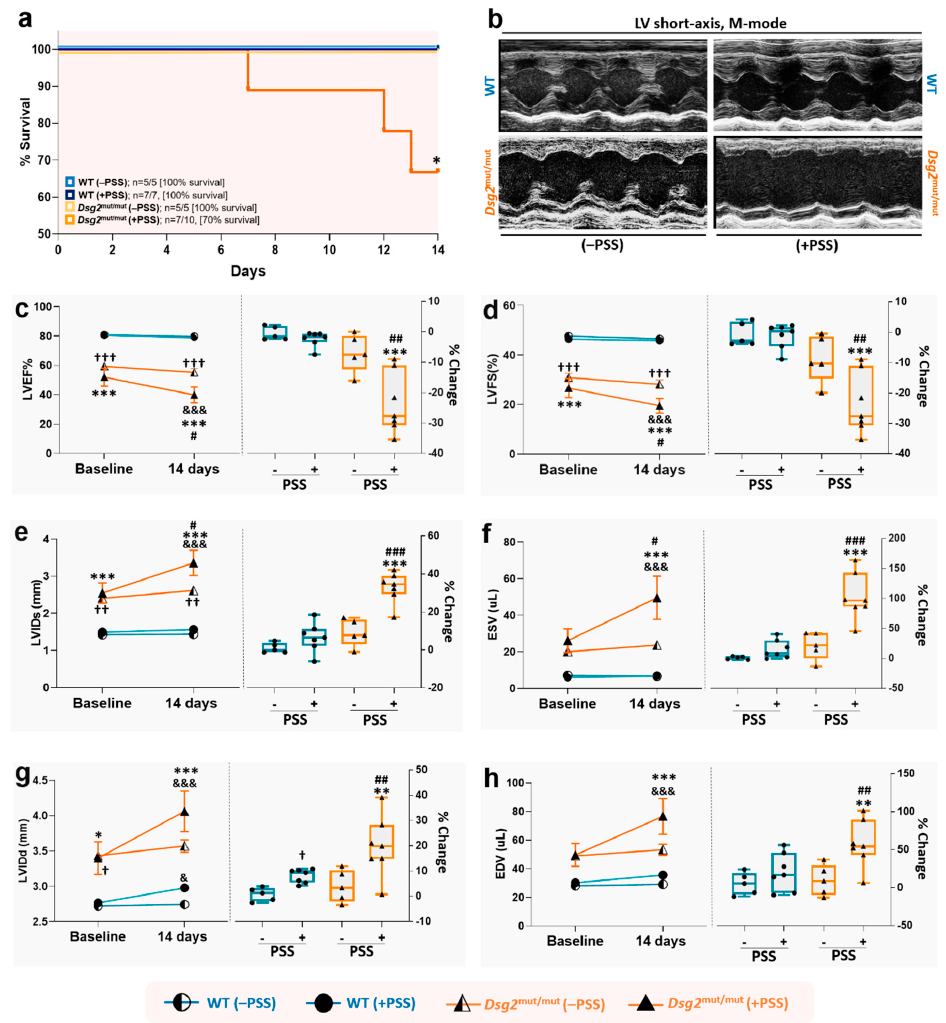
Figure 4. Psychosocial stress increases the risk of sudden death and worsens cardiac function in Dsg2 mut / mut mice. ( a ) Percent (%) survival curve in non-stressed (–PSS) and stress-induced ( + PSS) WT and Dsg2 mut / mut mice. PSS, psychosocial stress. Data presented as % survival and n-values inset; * p < 0.05 for Dsg2 mut / mut ( + PSS) vs. all cohorts via Wilcoxon survival test. ( b ) Representative left ventricular (LV) short-axis, m-mode echocardiography. Images representative of n = 5–7 mice / cohort. For c – h , the trend of echocardiographic parameters (y-axis) over time (x-axis) is shown on the left panels; and the percent changes (% Change) from baseline to the end of the protocol for each cohort, is shown on the right panels. ( c ) Percent Left Ventricular Ejection Fraction (LVEF%); ( d ) Percent Left Ventricular Fractional Shortening (LVFS%); ( e ) Left Ventricle Internal Diameter at systole (LVIDs; mm); ( f ) End Systolic Volume (ESV; µ L); ( g ) Left Ventricle Internal Diameter at diastole (LVIDd; mm); and ( h ) End Diastolic Volume (EDV; µ L). Data in left panels are presented as mean ± SEM; n = 5–7 mice / cohort / parameter; & p < 0.05; &&& p < 0.001 any cohort (at 14 days) vs. same cohort (at baseline) within cohort study, using two-way ANOVA with Sidak’s multiple comparisons post-hoc analysis; and * p < 0.01, *** p < 0.001 Dsg2 mut / mut ( + PSS) vs. WT ( + PSS) and WT ( − PSS); # p < 0.05 Dsg2 mut / mut ( + PSS) vs. Dsg2 mut / mut ( − PSS), † p < 0.05, †† p < 0.01, ††† p < 0.001 Dsg2 mut / mut ( − PSS) vs. WT ( + PSS) and WT ( − PSS), between cohort study, using two-way ANOVA with Tukey’s posthoc analysis. Data in right panels presented as box-whisker plots, n = 5–7 mice / cohort / parameter; ** p < 0.01, *** p < 0.001 Dsg2 mut / mut ( + PSS) vs. WT ( + PSS) and WT ( − PSS); † p < 0.05 WT ( + PSS) vs. WT ( − PSS); ## p < 0.01, ### p < 0.001 Dsg2 mut / mut ( + PSS) vs. Dsg2 mut / mut ( − PSS), using one-way ANOVA with Tukey’s post-hoc